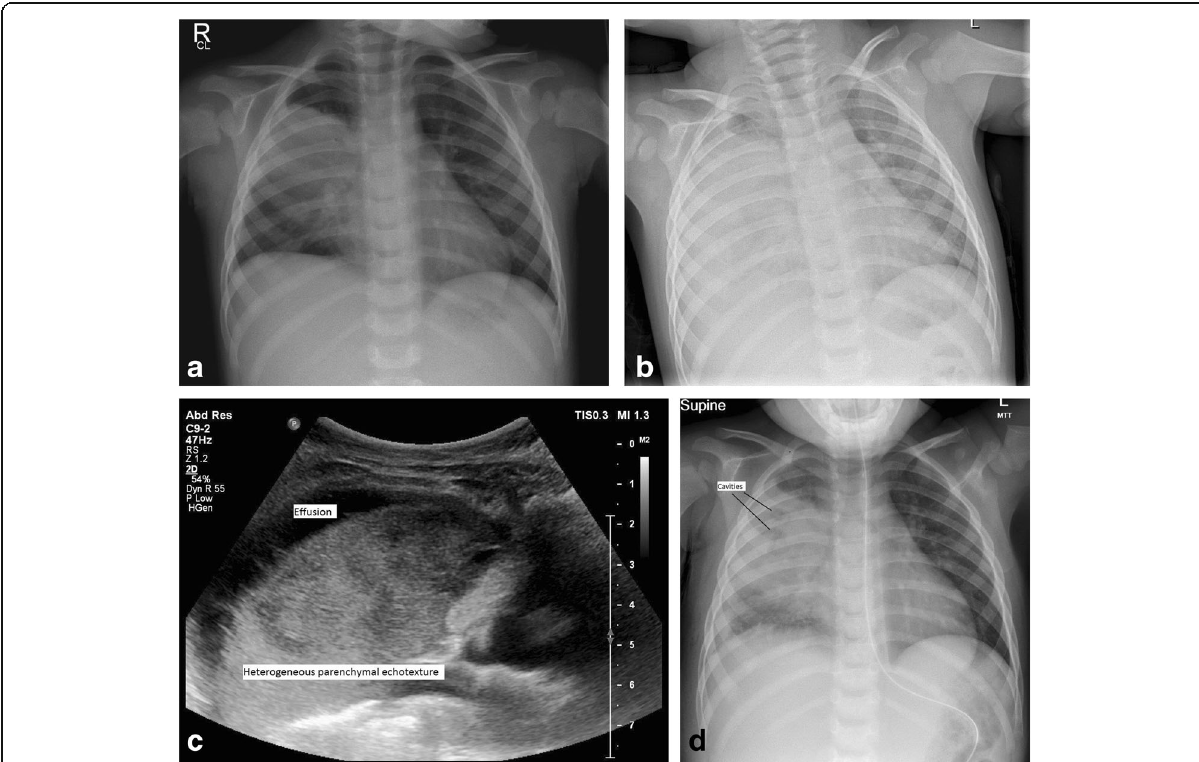
Fig. 1 A 2-year-old child presenting with 4 days of fever, cough, and intermittent grunting respirations. Pleural fluid tested positive for pneumococcal antigen. a Initial plain chest radiograph showing right mid-zone airspace opacity, consistent with pneumonia. b Plain chest radiograph 24 h later revealing a large right-sided pleural effusion. c Lung ultrasonographic image taken immediately afterwards depicting the pleural effusion and heterogeneous parenchymal echo texture, consistent with an underlying necrotizing pneumonia. d Plain chest radiograph 4 days later following thoracoscopy and removal of chest drains demonstrates right upper zone cavities within the region identified previously by